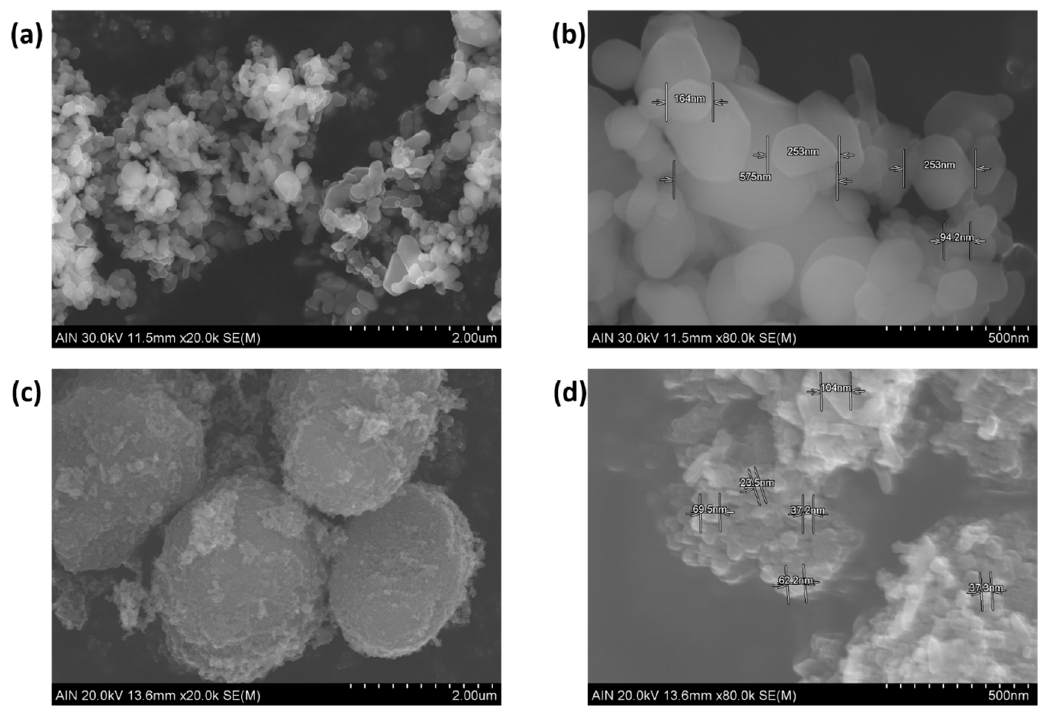
Figure 6. SEM images for Fe 2 O 3 ( a , b ) and TiO 2 ( c , d ) nanoparticles.